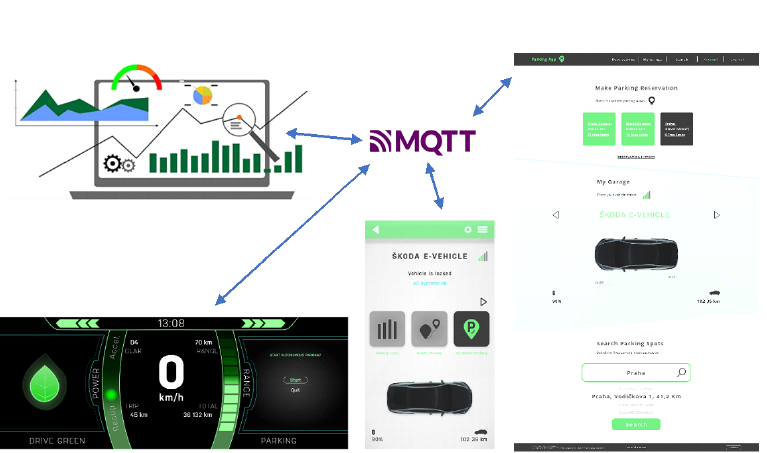
Figure 4. Practical illustration of the developed communication